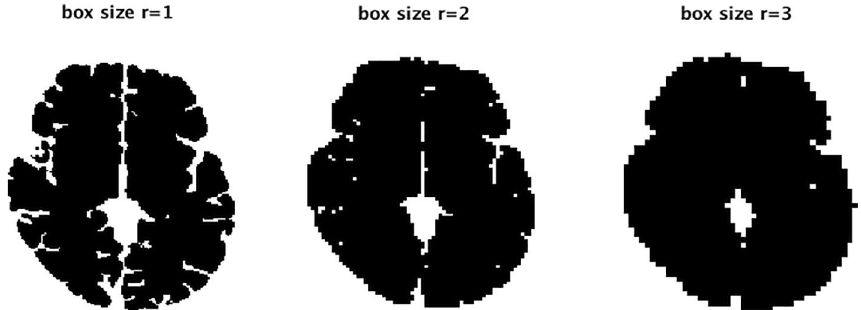
Figure 4. A two-dimensional illustration of the box-counting method for a trans axial slice, which is covered with boxes of increasing size. The section is extracted after the construction of boxes on three-dimensional brain mask.